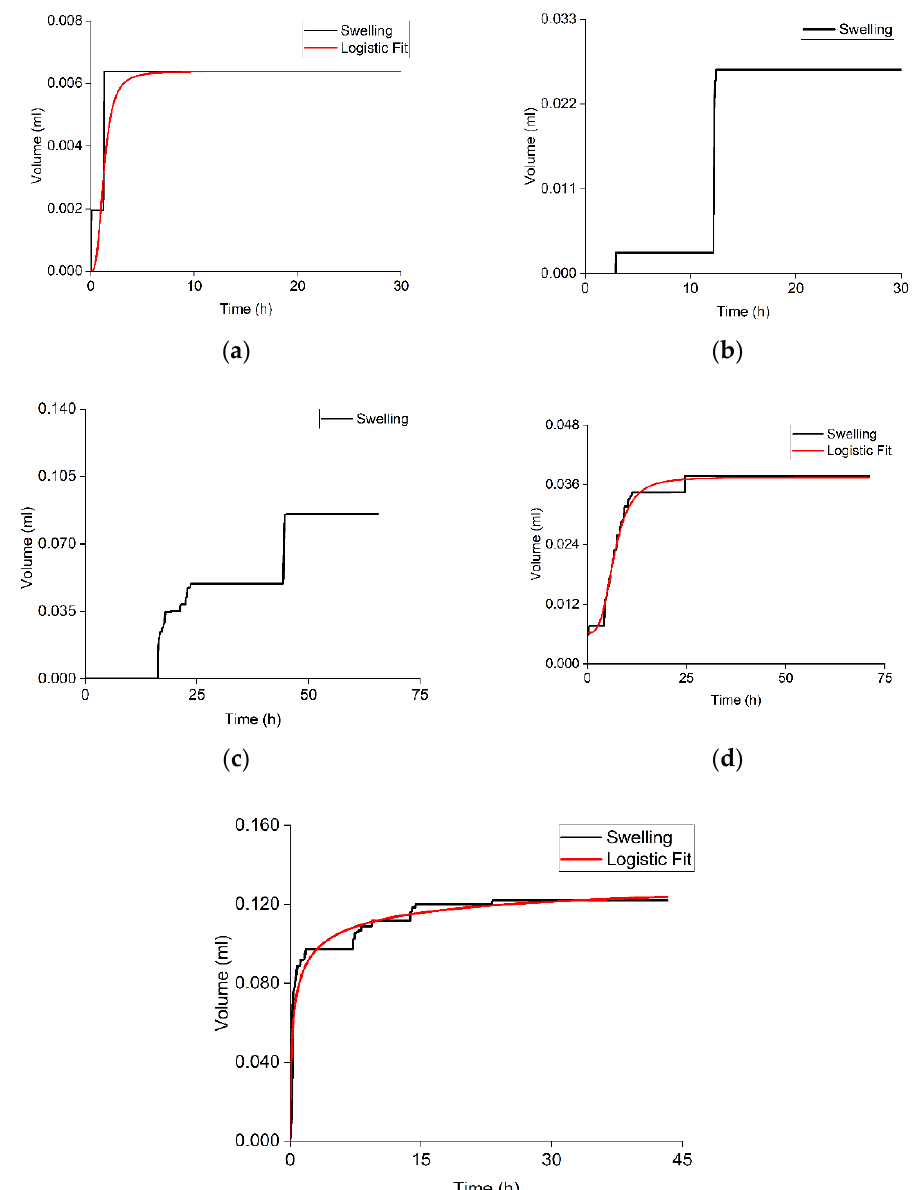
Figure 10. Sample rock volume change during swelling of the crushed rock samples in supercritical CO 2 in reservoir conditions, ( a – e ) for samples 1 – 5, respectively. Black curves show measured data, red curves show approximation with logistic function (see Equation (6)). Table 5. Results of the crushed rock swelling experiments in the presence of supercritical CO 2 . Volumetric expansion Sample